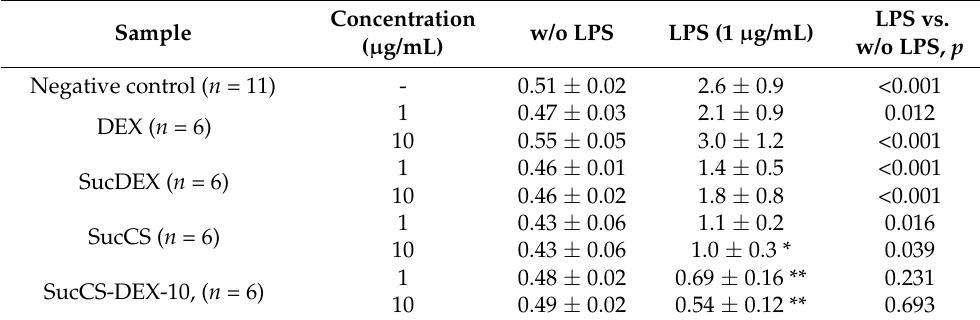
Table 6. The influence of DEX, SucDEX, SucCS, and SucCS-DEX-10 solutions on CD54 expression on THP-1 cells under the LPS-stimulated inflammatory conditions, mean ±